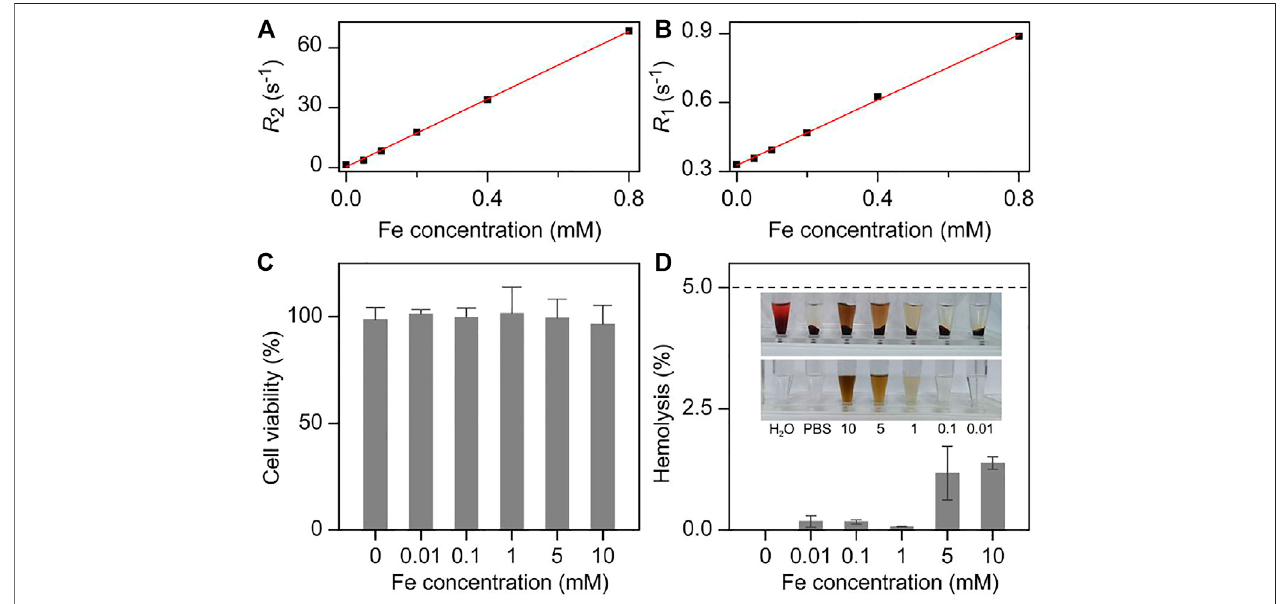
FIGURE2| Feconcentrationdependent (A) R 2 and (B) R 1 togetherwiththecorrespondinglinear fi ttingsforextractingthemolarrelaxivitiesofFe 3 O 4 nanoparticles, respectively. (C) Viabilities 3T3 cells treated with nanoparticles at different concentrations. (D) The hemolysis rate analysis of Fe 3 O 4 with different concentrations. Inset: the photographs of different solutions containing blood cells after centrifugation (top) , together with the nanoparticles PBS solutions with corresponding concentration as the absorbance backgrounds (bottom) .